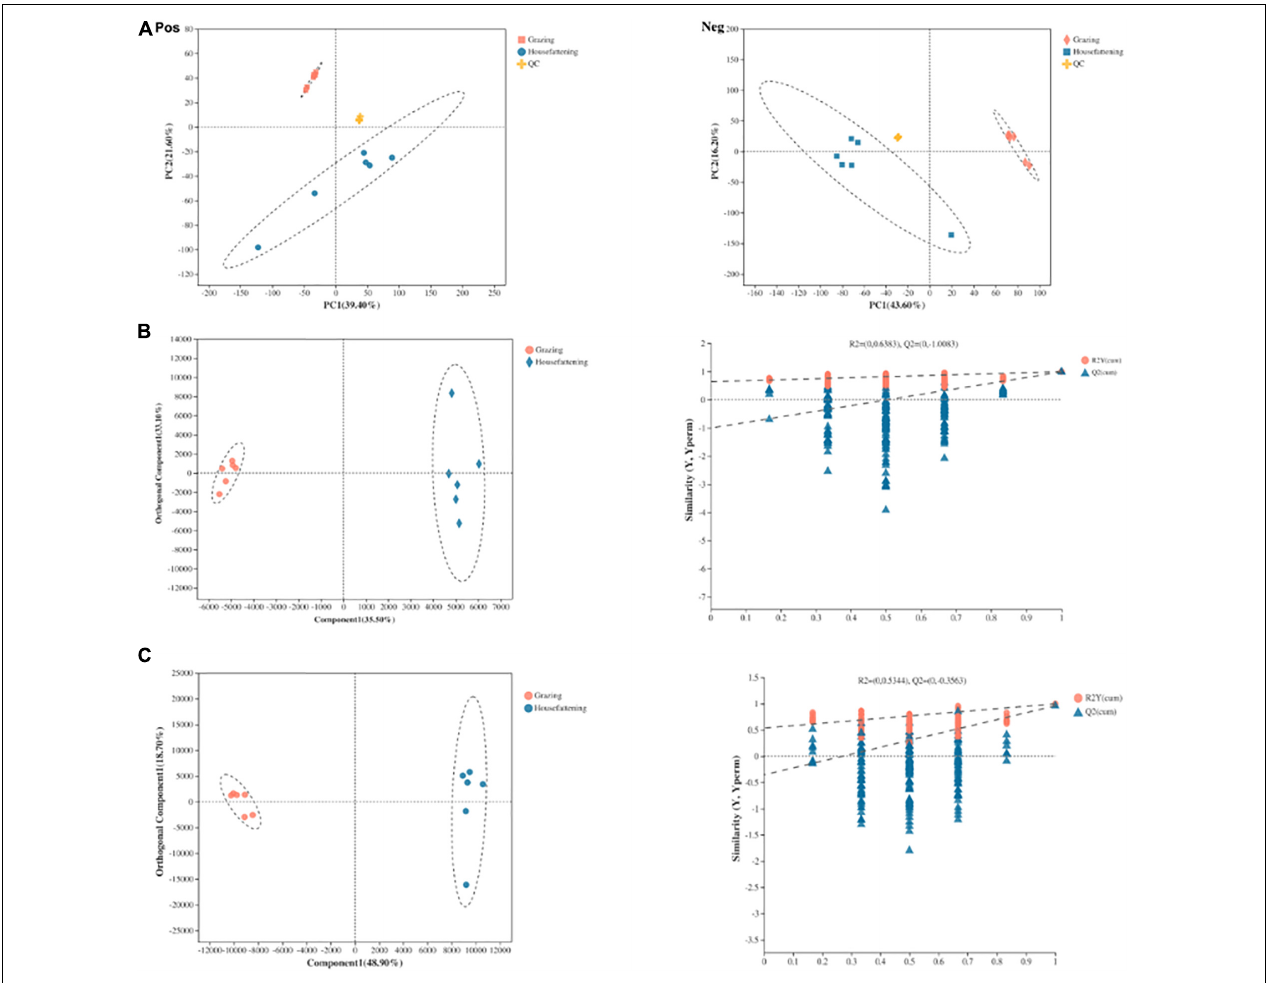
FIGURE 5 | Principal component analysis (PCA) score plots of metabolic profiling in positive (Pos) and negative (Neg) ion mode (A) . OPLS-DA models of positive (B) and negative (C) mode ionization. Different colors represent different groups; pink, grazing group; blue, house fattening group; yellow, QC group.